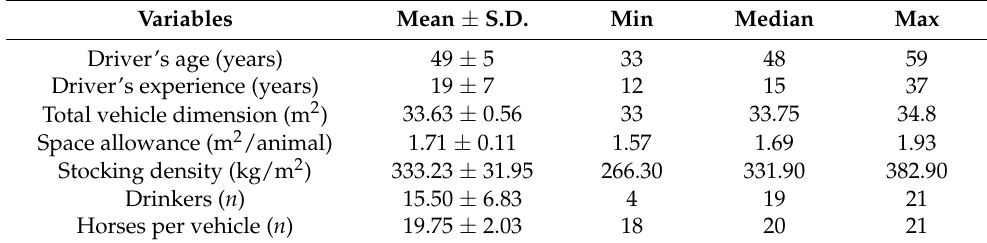
Figure 2. One of the vehicles arriving at the slaughterhouse in Southern Italy. ( a ) The truck and the straight-frame semi-trailer where horses were transported; ( b ) the interior of the vehicle observed after the horses were unloaded. Table 8. Descriptive statistics for the variables related to driver’s information and journey